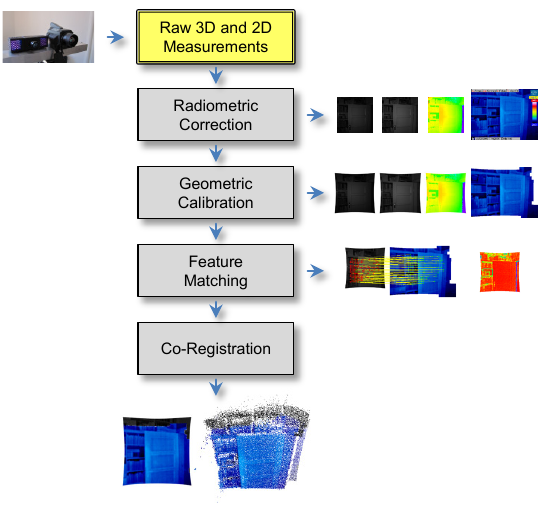
Figure 1: The components of our